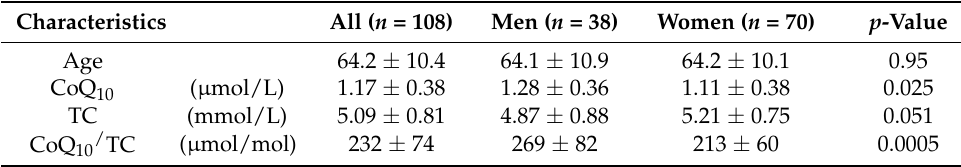
Table 2. Baseline characteristics of the participants included in the analysis.